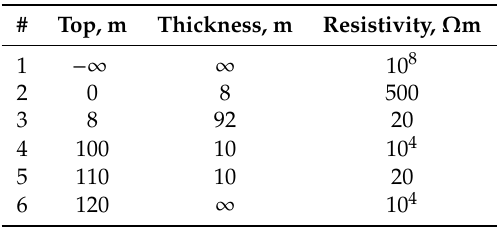
Table 1. The background 1D resistivity